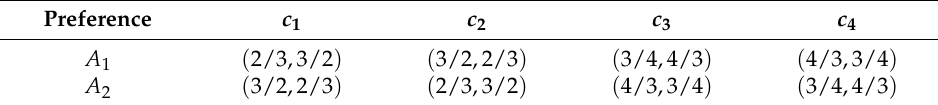
Table 3. The indifference relation between A 1 and A 2 if n is even.